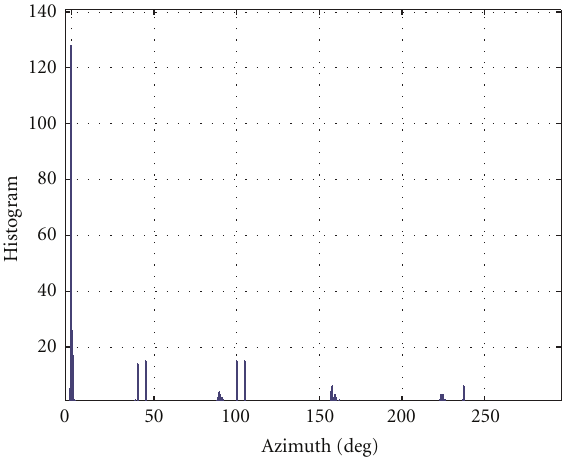
Figure 8: Histogram plot of estimated azimuth angles using ESPRIT algorithm when mutual coupling is